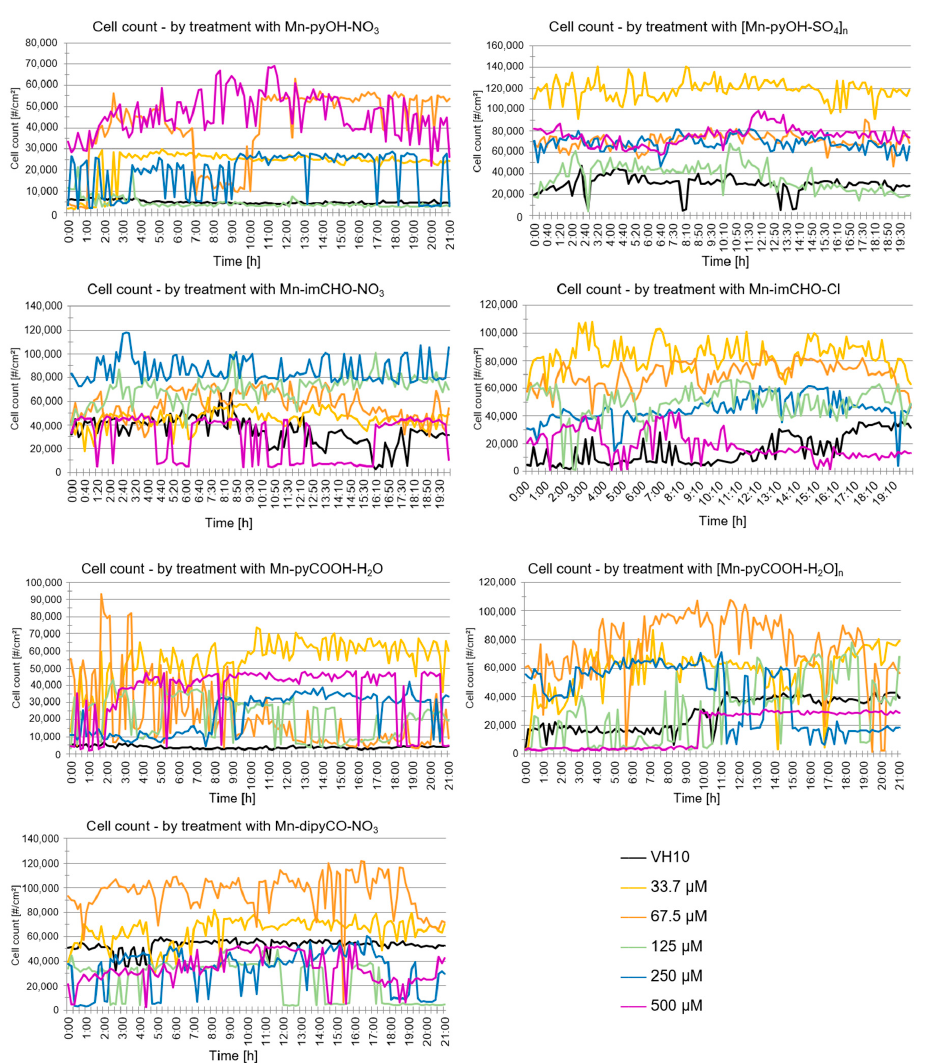
Figure 11. Analysis of VH10 cell count over time following the Mn(II) complexes treatment acquired using the HoloMon-